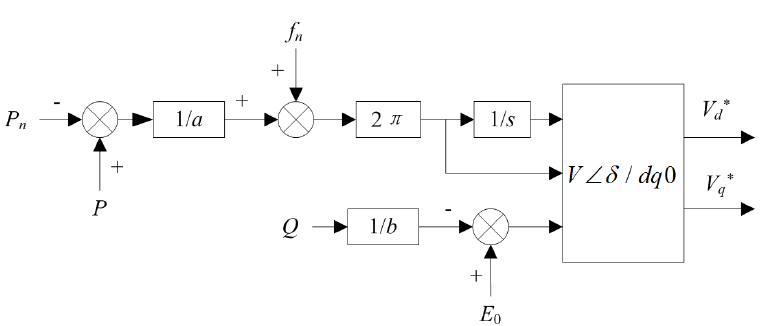
Figure 3. Droop based V/f